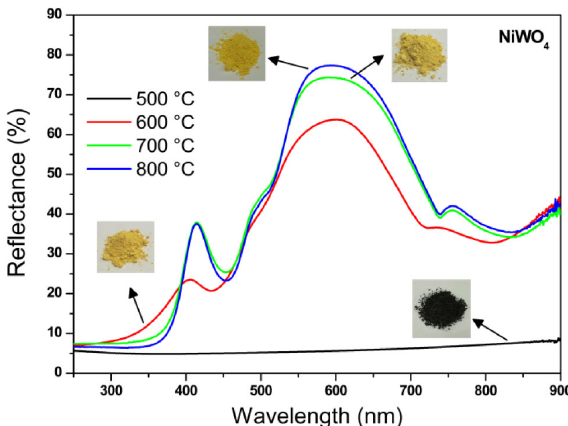
Fig. 3 Reflectance spectra of NiWO 4 samples calcined at 500–800 ℃ /2 h.